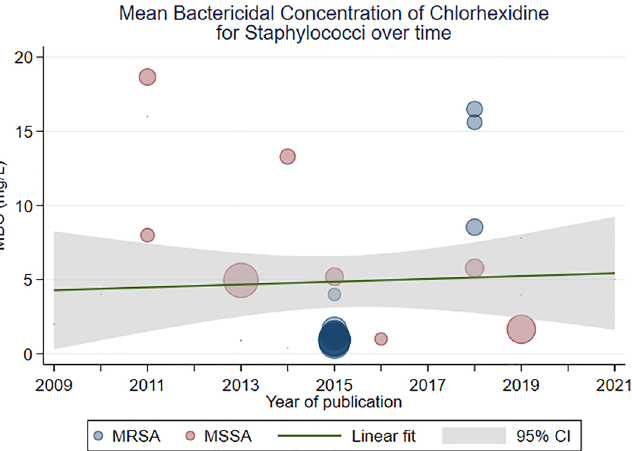
Figure 3. A scatterplot of study-level estimates of mean MBC over time, for Staphylococci . The size of the points corresponds to the precision (inverse variance) of the study, whereby larger bubbles are more precise (bigger and so, more accurate) studies.